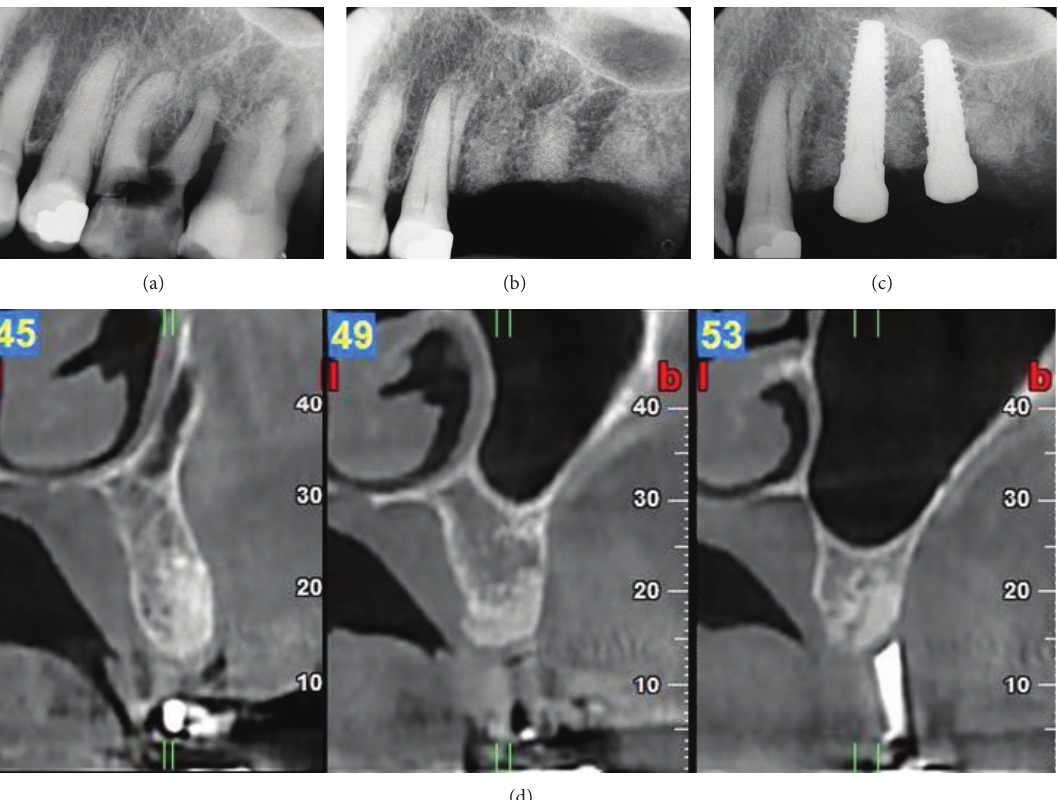
Figure 7: Radiographic views of Case 1. Periapical radiographs (a) before extractions, (b) at 6 months, and (c) after implant placement. (d) CBCT images at 6 months postoperatively.